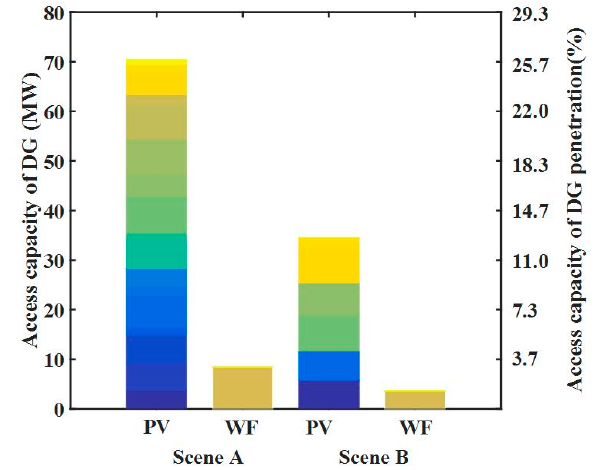
Figure 7. The DG accommodation capacity of each node under two scenes.